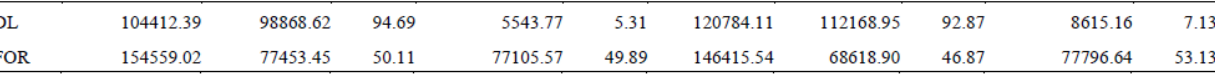
Table 7. Area of dry land and forest distributed on the plain and slope region (over 4